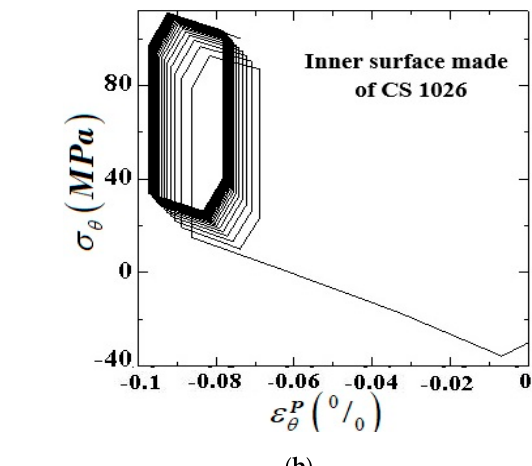
Figure 5. Representative stress–plastic strain hysteresis loops along the hoop direction of an FGM pipe with outer surfaces made of CS 1026 under sustained internal pressure plus cyclic bending loading for various types of elastic–plastic behaviors. ( a ) Elastic shakedown under P in = 0.33 P y and M = 1.85 M y ; ( b ) plastic shakedown under P in = 0.24 P y and M = 2.75 M y ; ( c ) ratcheting under P in = 0.94 P y and M = 3.8 M y .